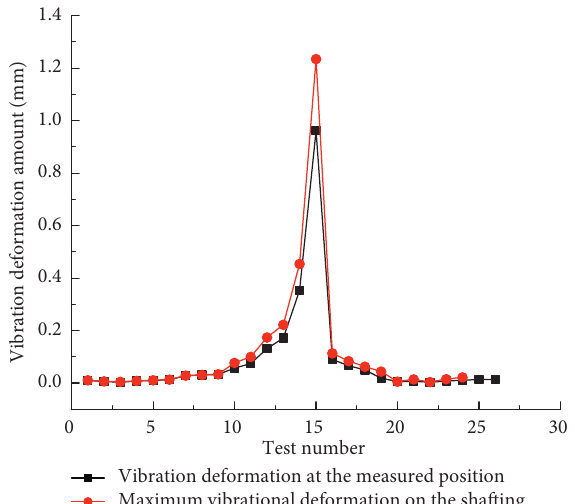
Figure 8: Relationship between x and vibration I × II